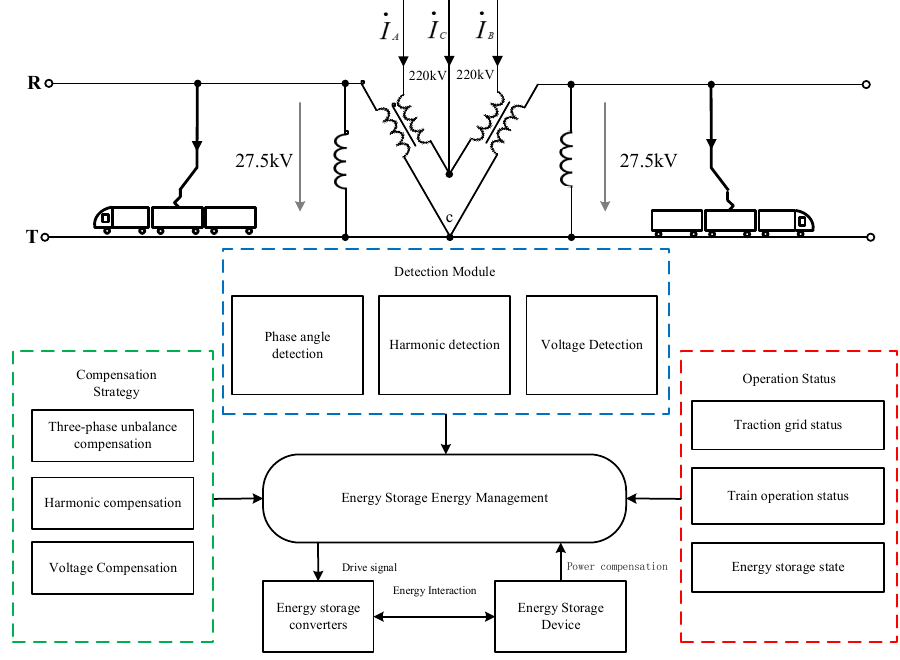
Figure 31. Block diagram of integrated power quality compensation logic.